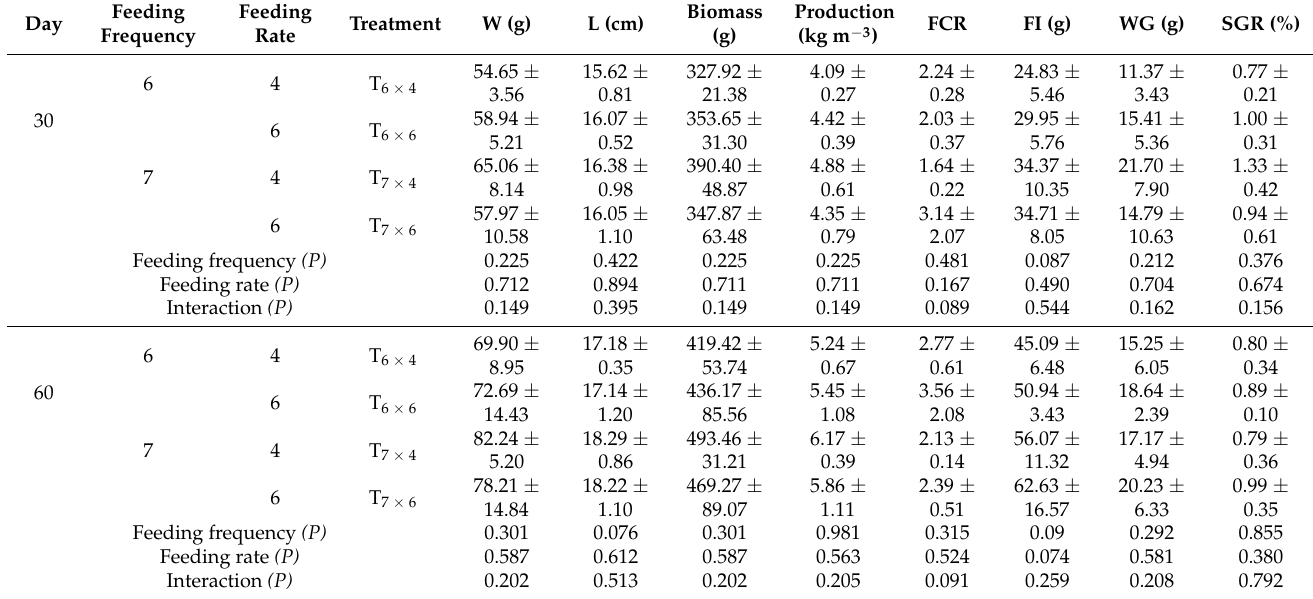
Table 2. Growth performance (mean ± SD) for weight (W, g), total length (L, cm), biomass (g), production (kg m − 3 ), feed conversion rate (FCR), feed intake (FI, g), weight gain (WG, g), and specific growth rate (SGR, %) for Colossoma macropomum juveniles grown under BFT with different weekly feeding frequencies and feeding